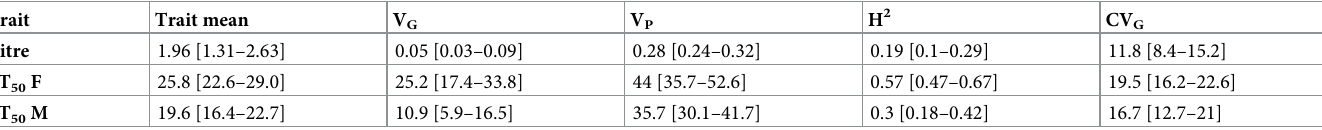
measure of genetic variation) in viral titre and LT50 values in females, and LT50 values in males (Table 1). Our estimates of H 2 and CV fall within the range found for resistance to other path- G ogens in the DGRP, although direct comparison is difficult as studies are inconsistent in the sta- tistics used to report genetic variation. H 2 in survival following infection with an opportunistic Table 1. Trait means, genetic variance (V G ), total phenotypic variance (V P ), heritability (H 2 ), and coefficient of genetic variation (CV G ) in titre and mortality fol- lowing KV infection in the DGRP. Trait Trait